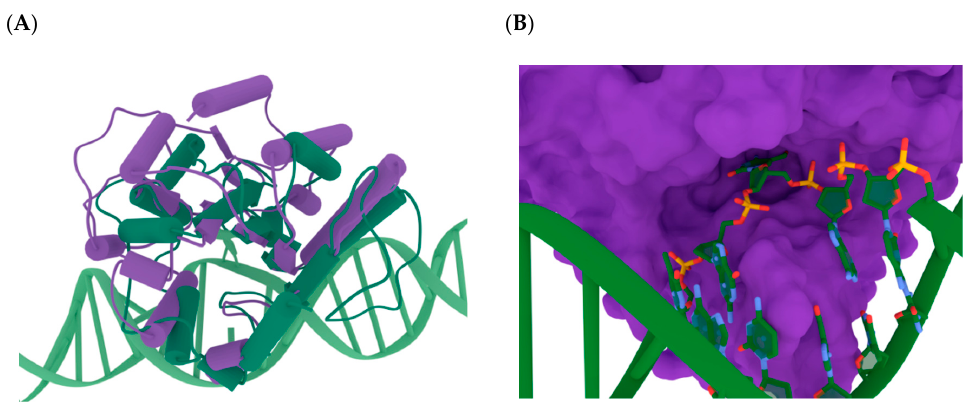
Figure 2. ( A ) Structural alignment of hTDG (PDB ID 5T2W, green) and hSMUG1 (model, purple) with DNA. Protein α -helices (pipes) and β -strands (planks) and DNA coil ribbons are shown. ( B ) Combination of the DNA from the 5T2W structure with the solvent-accessible surface of hSMUG1. The uracil base was found to be snugly located in the hSMUG1 active-site pocket. The intercalating loop of hSMUG1 precisely fitted into the appropriate void of